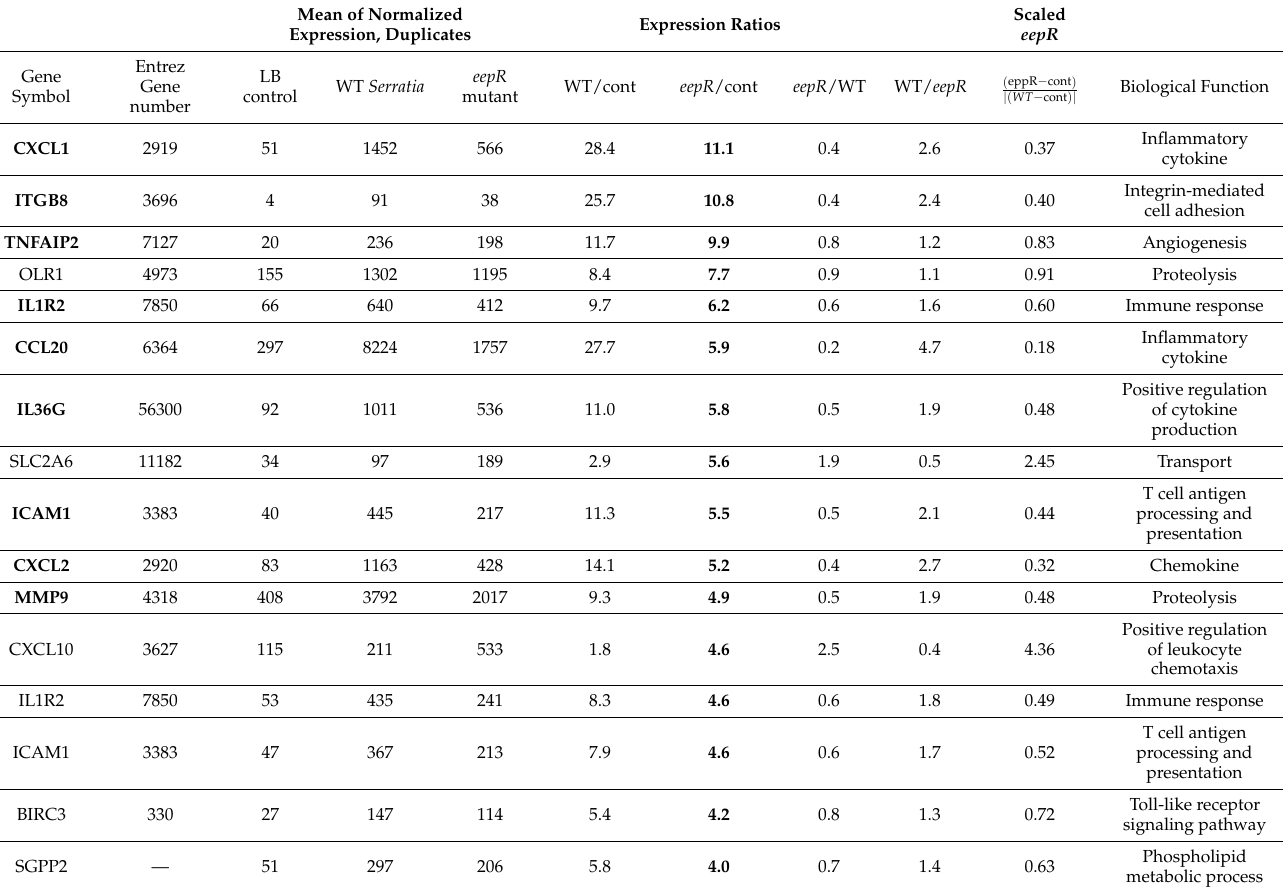
Table 3. Twenty-five genes with the greatest expression increase in cells treated with eepR vs. mock secretomes. Mean of Normalized Expression,